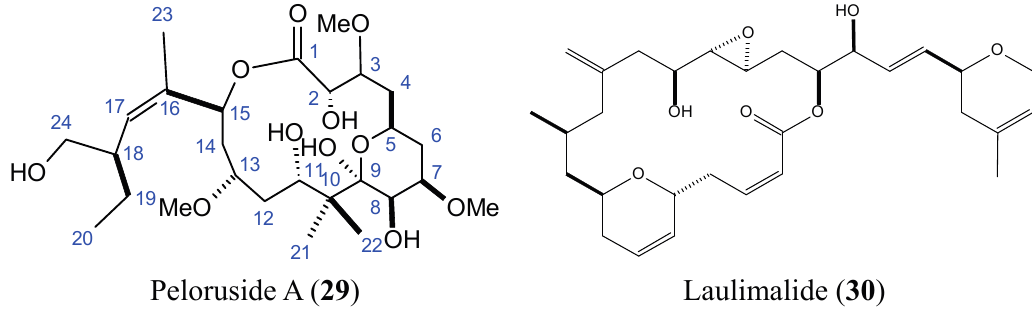
Figure 11. Peloruside A and